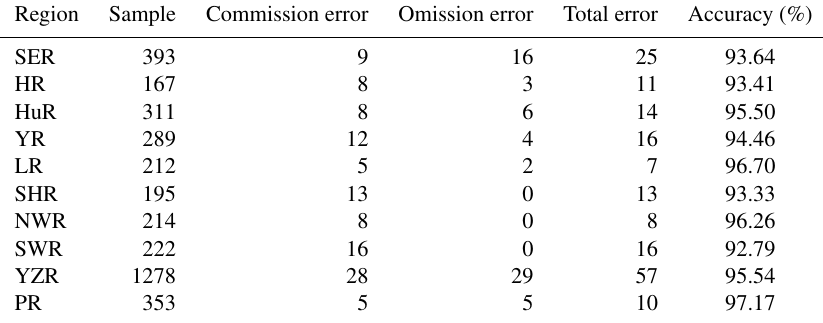
Table 3. Accuracy validation in each river basin.